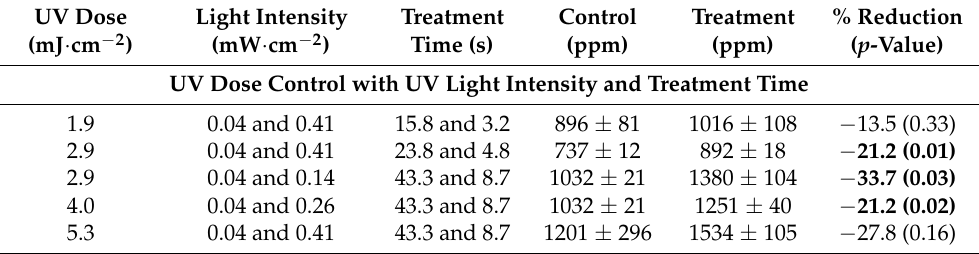
Table 4. Mitigation of CO 2 with UV-A photocatalysis treatment. Control temperature = 28.5 ± 2.3 ◦ C, in the table are mean ± S.D. Bold signifies statistical significance.